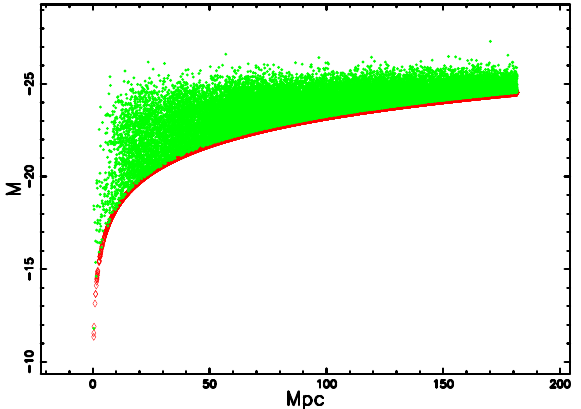
Figure 7. The absolute magnitude M of 36,474 galaxies belonging to the 2MRS when M(cid:12) = 3.39 and H 0 = 70 km s − 1 Mpc − 1 (green points). The lower theoretical curve as represented by Equation (55) is shown as the red-thick line when m L =